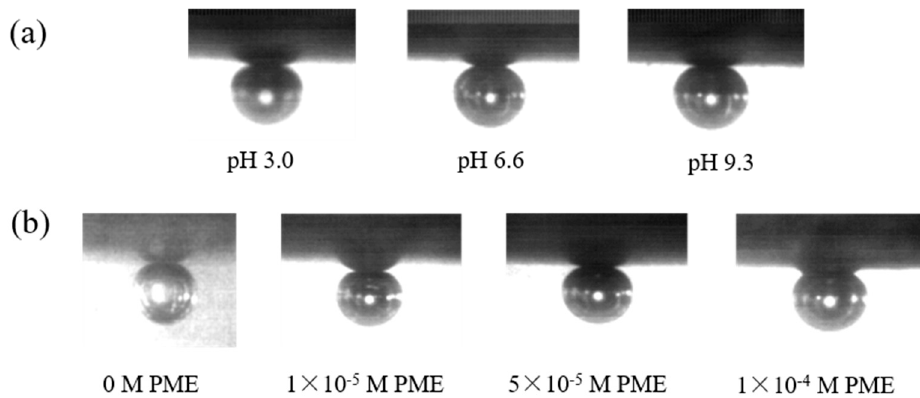
Figure 2. Captive bubble contact angle at a barite surface with 2.5 × 10 − 5 M PME as a function of pH ( a ); and captive bubble contact angle at a barite surface with pH 6.3 as a function of PME concentration ( b ).